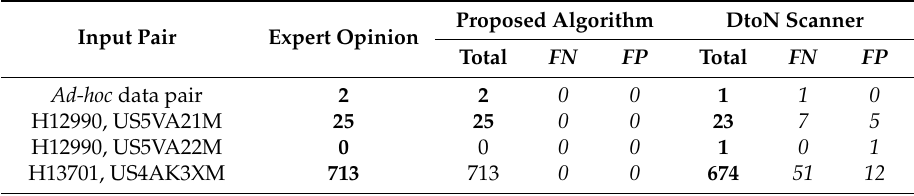
Table 6. Results for DtoN candidates using the proposed algorithm and the DtoN Scanner [25]. The Expert Opinion column provides the total number of DtoNs used to identify the false negatives (FN) and the false positives (FP) for the two sets of automated outputs.